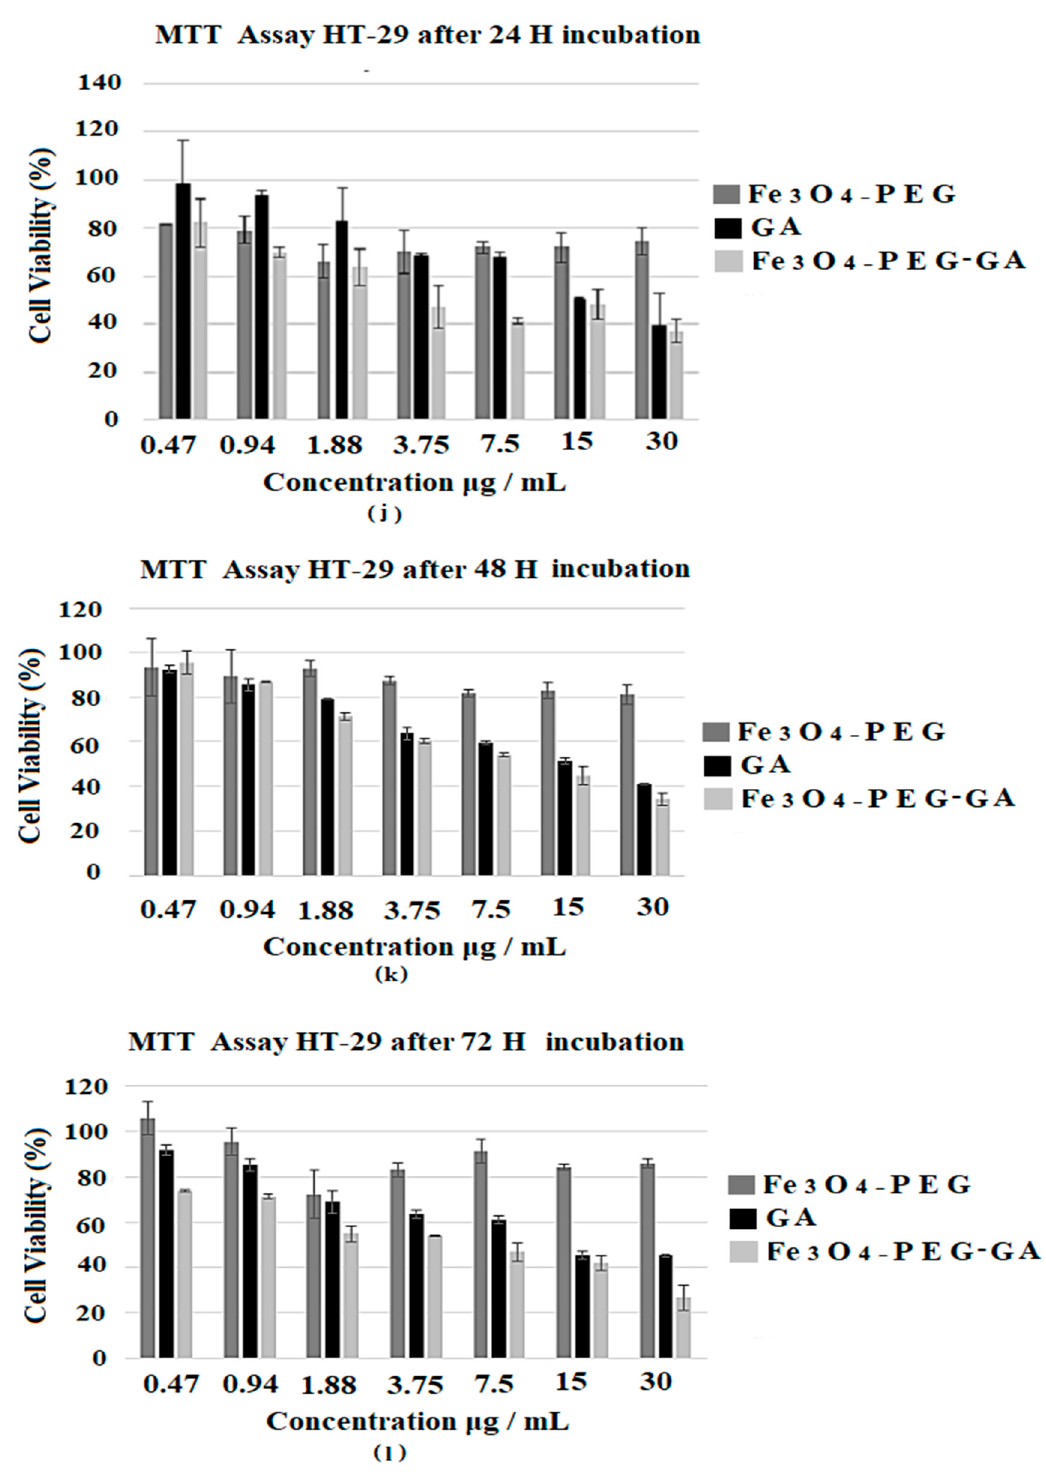
Figure 2. ( a – c ) shows the cell viability (%) of 3T3 cells estimated by MTT assay after 24, 48 and 72 h incubation respectively; ( d – f ) shows the cell viability (%) of A549 cells estimated by MTT assay after 24, 48 and 72 h incubation respectively; ( g – i ) shows the cell viability (%) of MCF-7 cells estimated by MTT assay after incubation for 24, 48 and 72 h respectively; ( j – l ) shows the cell viability (%) of HT-29 cells estimated by MTT assay after 24, 48 and 72 h incubation respectively.